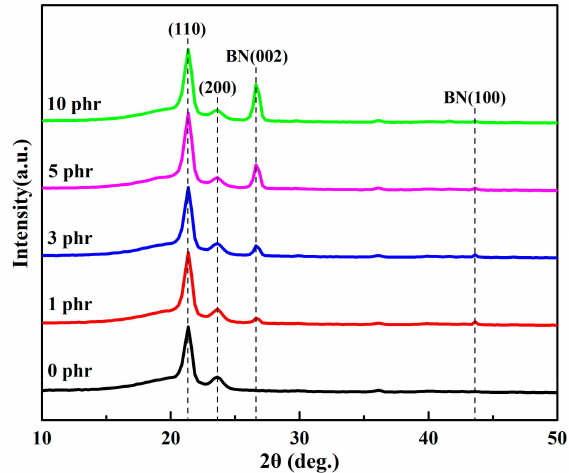
Figure 1. XRD images of h-BN / LDPE (hexagonal boron nitride / low-density polyethylene) composites with di ff erent h-BN fillers contents and